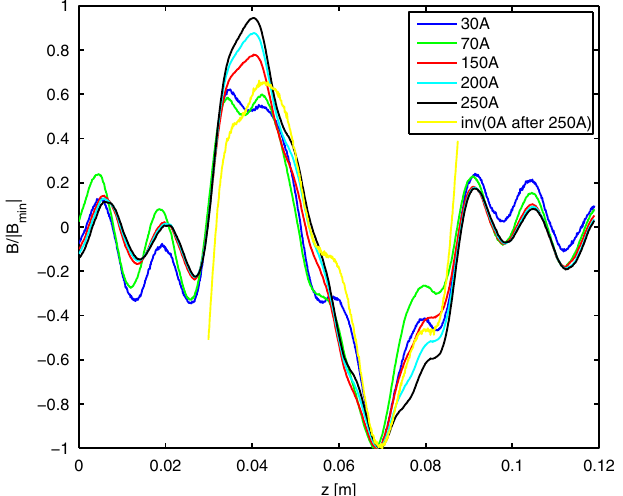
FIG. 8. Reduction of the first field integral by the loop system measured along the loop system for I main ¼ 70 A . The dashed curves show the ratio before compensation, the solid lines after compensation. The values of the solid lines increase towards both ends of the area covered with YBCO loops especially for currents above I main ¼ 150 A . This is caused by two effects: (1) The induced currents reach the saturation current, in the right loops for 150 A (cid:6) I main (cid:6) 250 A (see Table I) and in the first loop at the left-hand side at I main * 70 A due to a fabrication error. This is the cause for the higher values at point 1 at the left-hand side of Fig. 10. (2) At both ends of the loop system the values in Fig. 10 are higher since the outmost loops have no partner due to the finite length of the induction-shimming system (see Figs. 3 and 4).